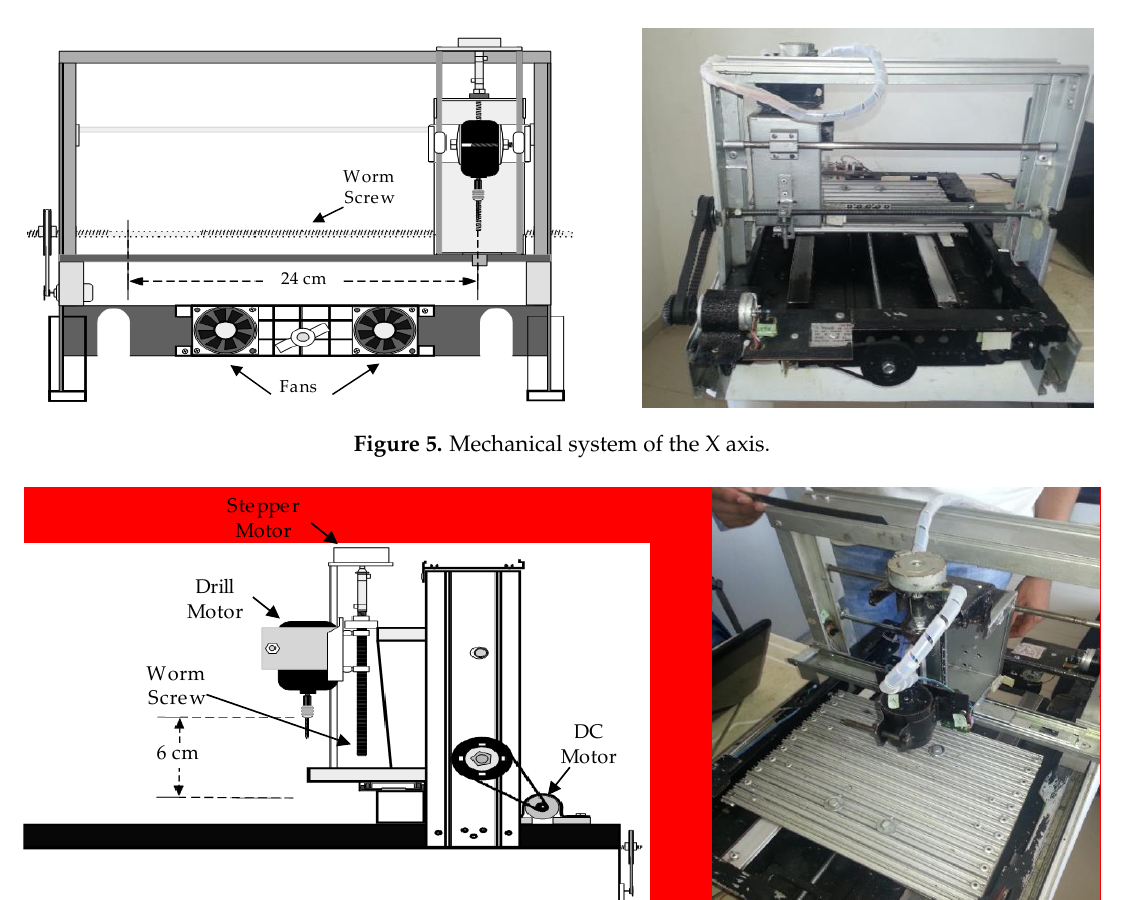
Figure 6. Mechanical system of the Z axis.